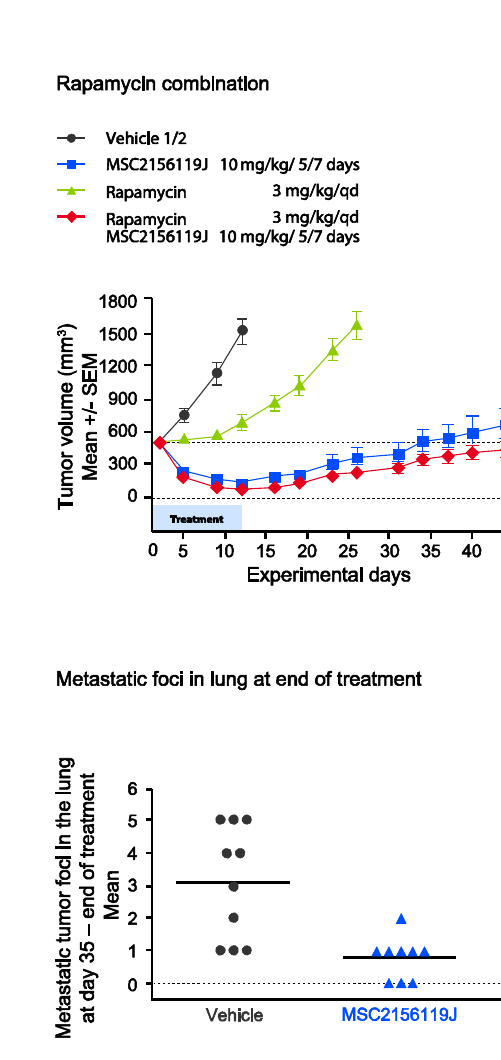
Figure 1. Efficacy of MSC2156119J in a patient-derived HCC xenograft model. ( A ) MHCC97H, subcutaneous setting; ( B ) MHCC97H, orthotopic setting. Treatment of MSC2156119J (10 mg/kg/5/7 days) started one week after tumor fragment